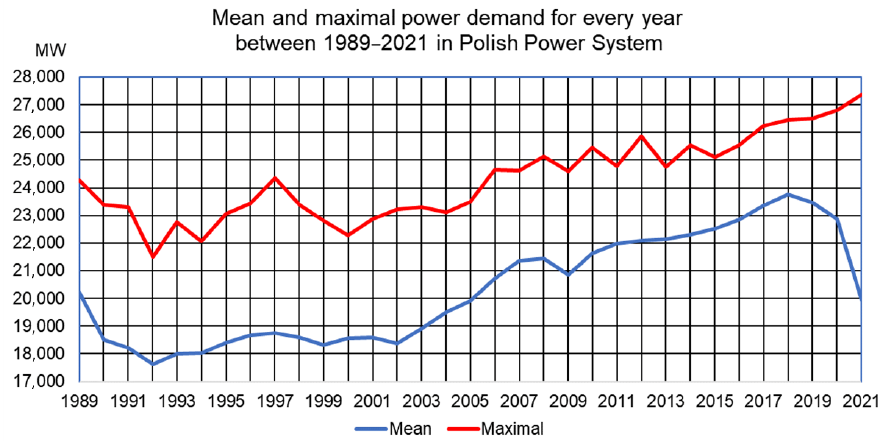
Figure 1. Mean and maximal power demands in MW, for every year between 1989 and 2021 in Polish Power System [17]. Power System [17].